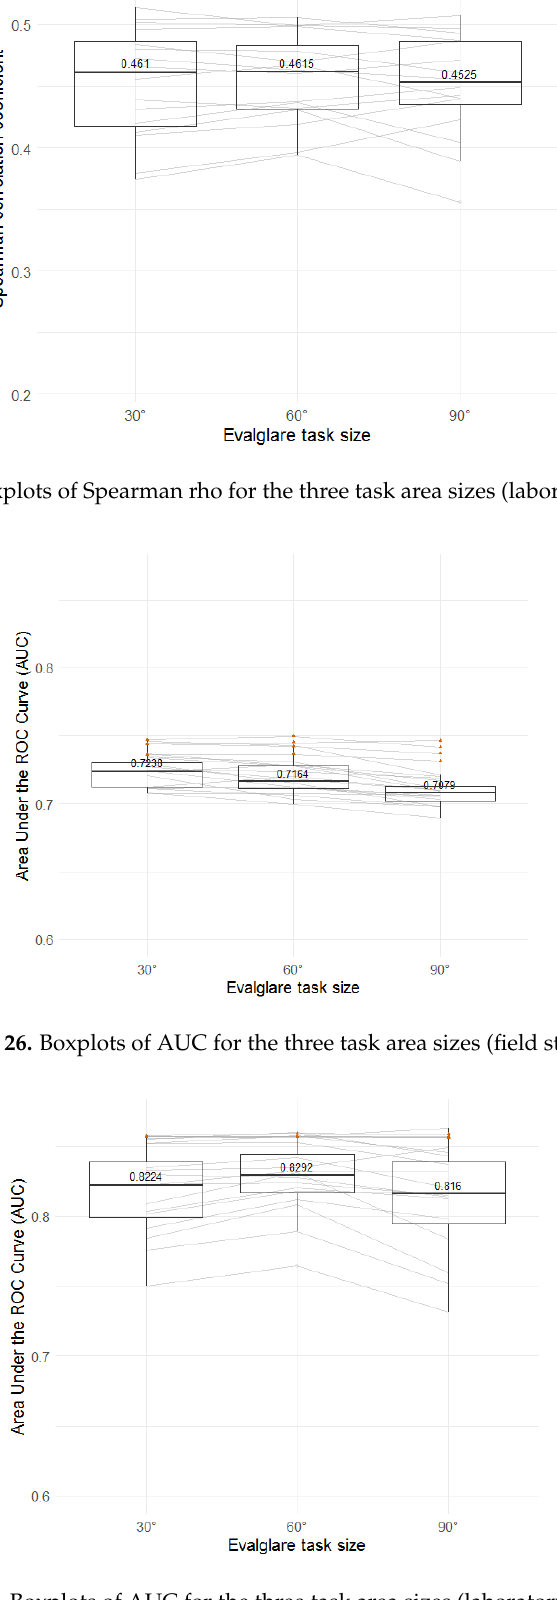
Figure 24. Boxplots of Spearman rho for the three task area sizes (field study).